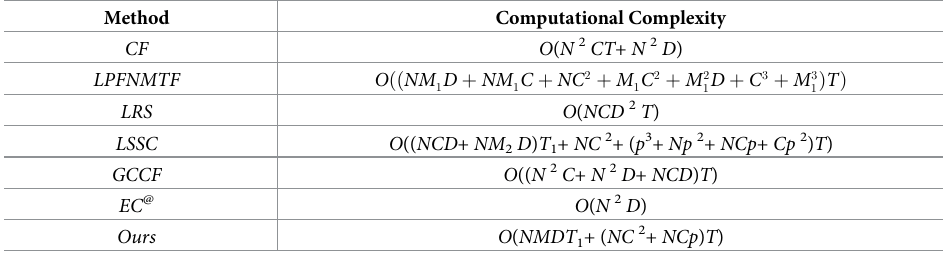
Table 2. Computational complexity